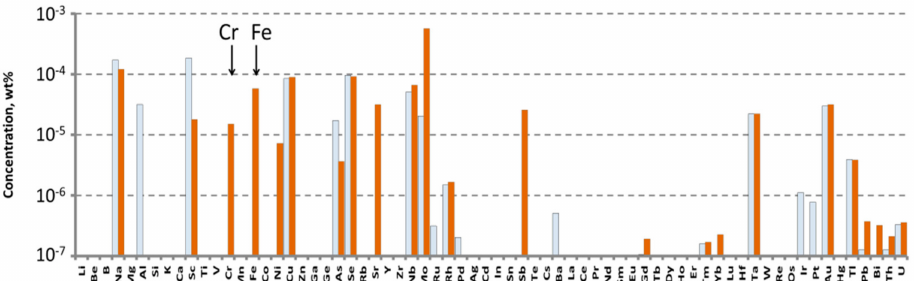
Figure 5. Impurities concentrations in the crystal-etalon (orange bars), and the “pure” crystal (white bars) determined by